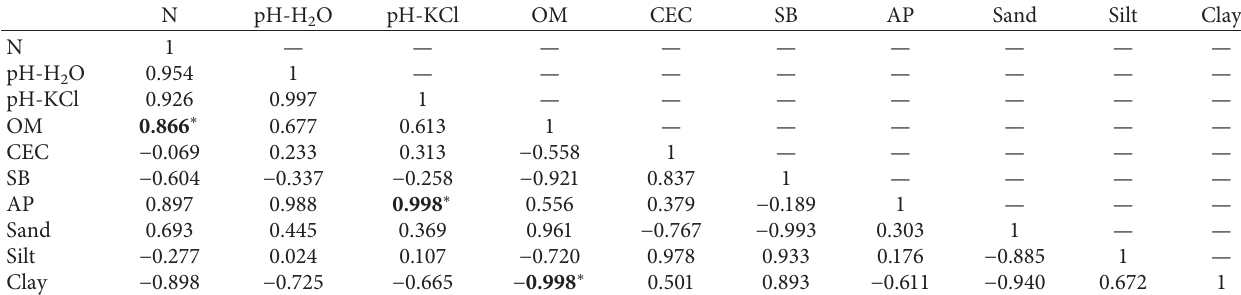
Table 5: Correlation between soil physicochemical properties.